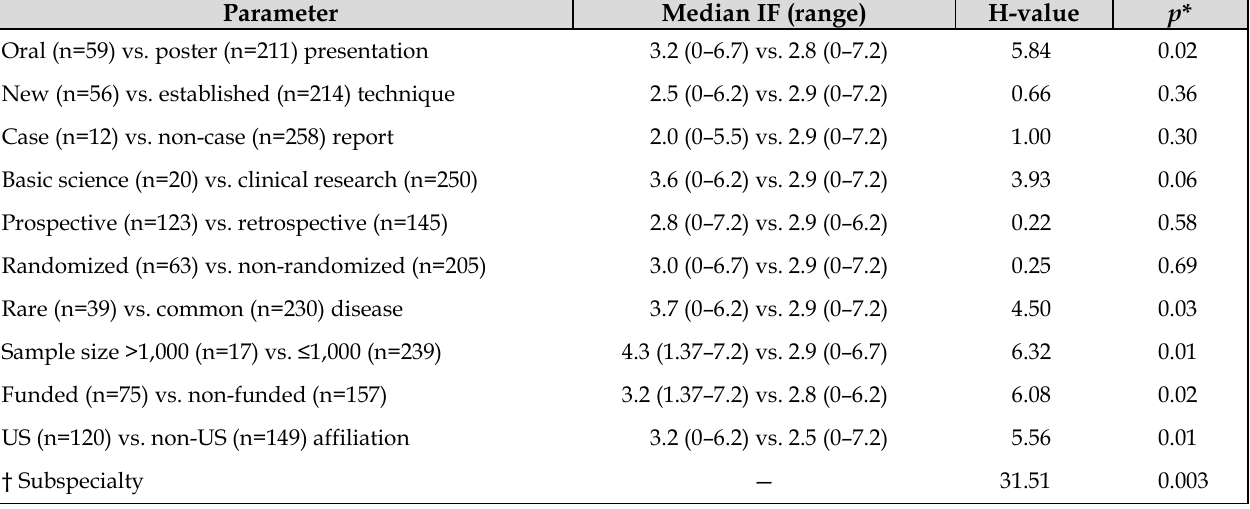
Table 4 Univariate analysis of factors and the impact factor (IF) of the journal in which they were